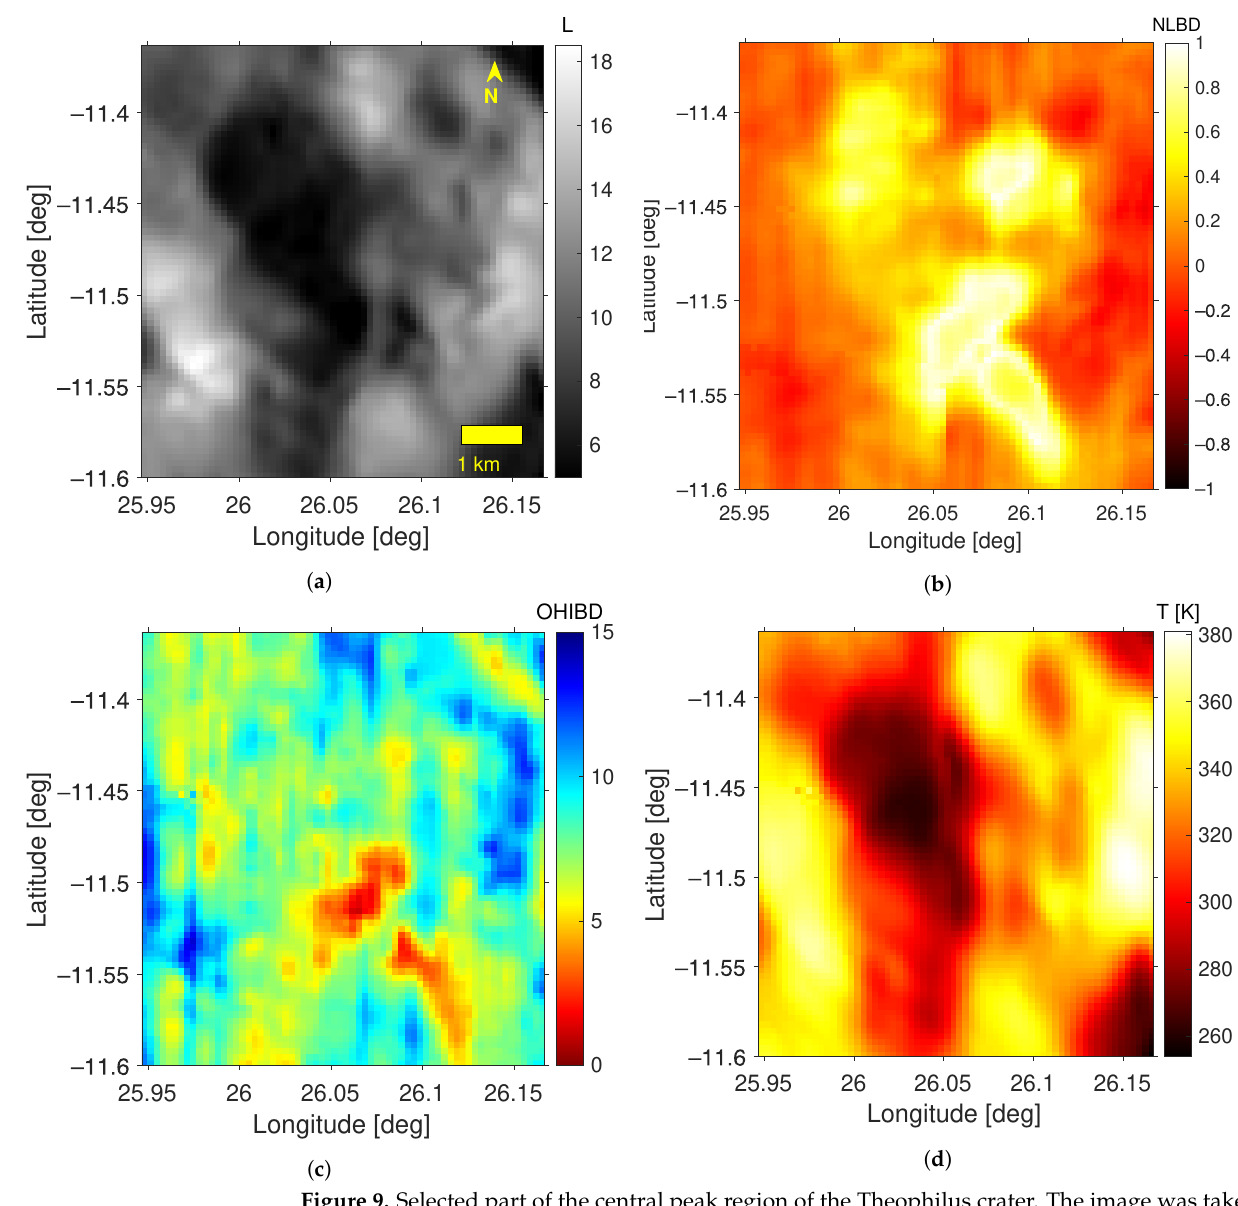
Figure 9. Selected part of the central peak region of the Theophilus crater. The image was taken at 08:45 local time. ( a ) radiance, ( b ) NLBD, ( c ) OHIBD (percent), ( d ) Temperature